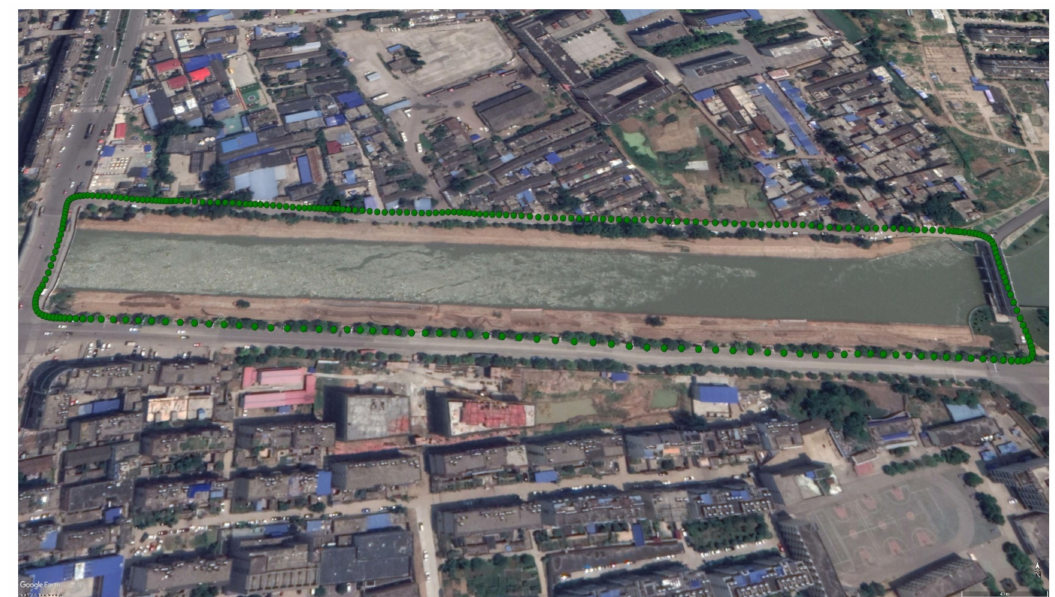
Figure 8. Real environment